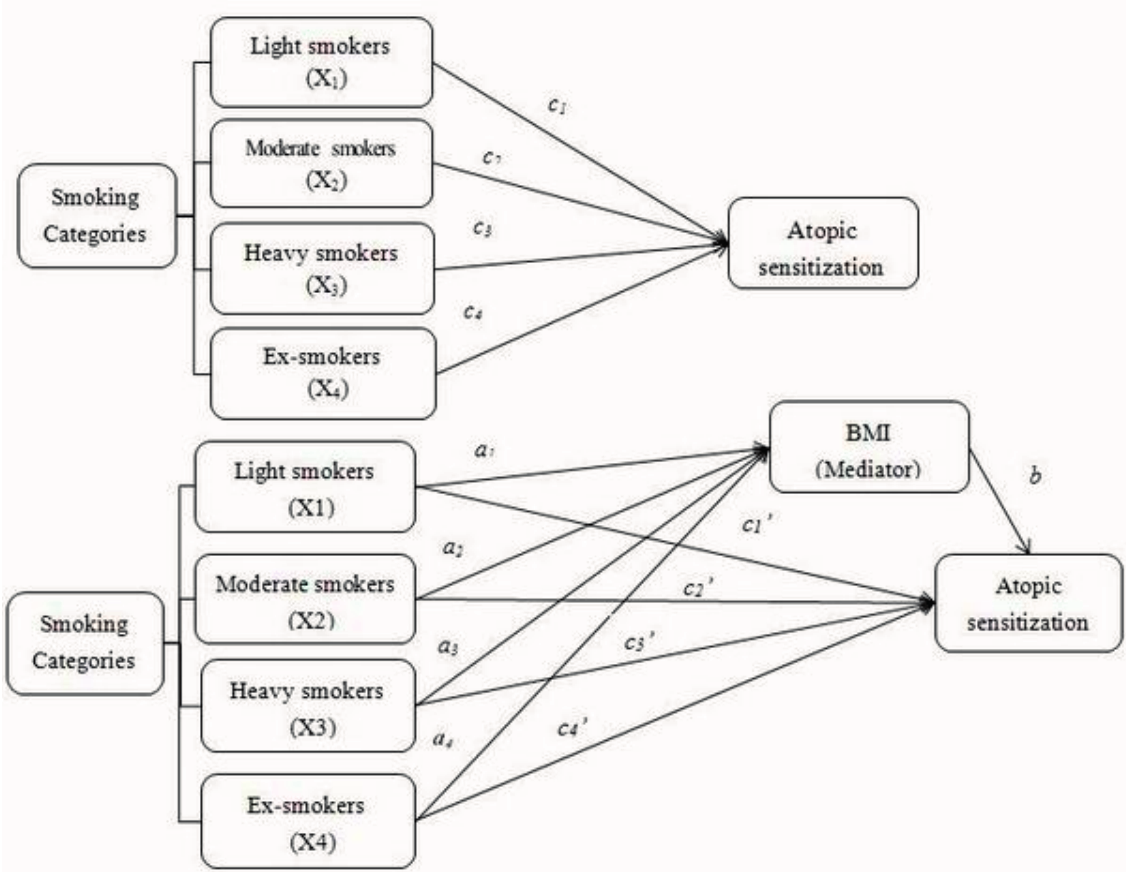
Figure 1. Model of the potential mediating effect of BMI on the association betweensmoking categories and atopic sensitization. The figure shows how to estimate the indirect effects through the potential mediator, of one smoking category (X 1 , X 2 , X 3 and X 4 ) on atopic sensitization compared to non-smoking category. Total effects ( c paths ) represent the overall association of a smoking category with atopic sensitization. Mediating effect occurred when the overall association could be partially (or fully) explained by the potential mediator (BMI). Association of the potential mediator with each smoking category ( a paths ) and the association with atopic sensitization independent of each smoking category were estimated. The products of abs ( a 1 b , a 2 b , a 3 b , a 4 b ) were used for estimating the indirect effects of BMI on the association between each smoking category and atopic sensitization. The “c” paths’ represent the direct effects of each smoking category and atopic